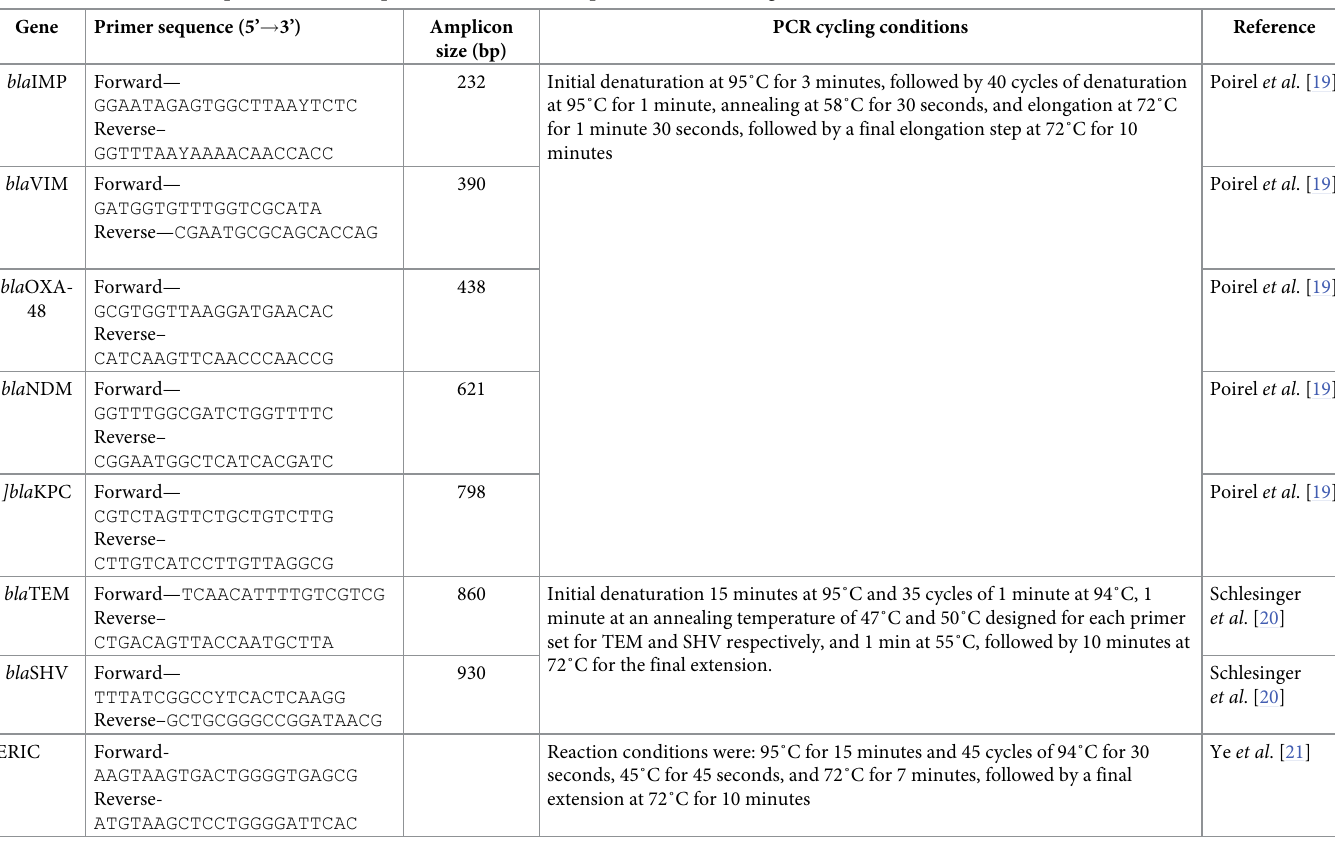
Table 1. Primer sets for amplification of carbapenemase and extended spectrum β -lactamase genes. Gene Primer sequence (5’ !